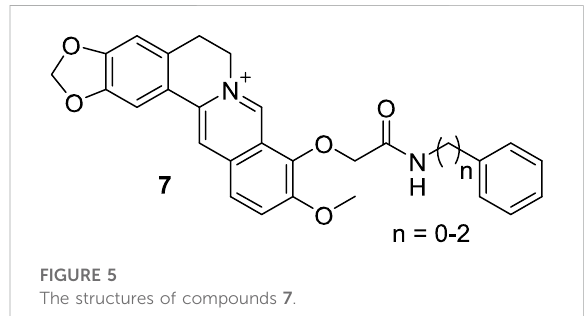
FIGURE 5 The structures of compounds 7